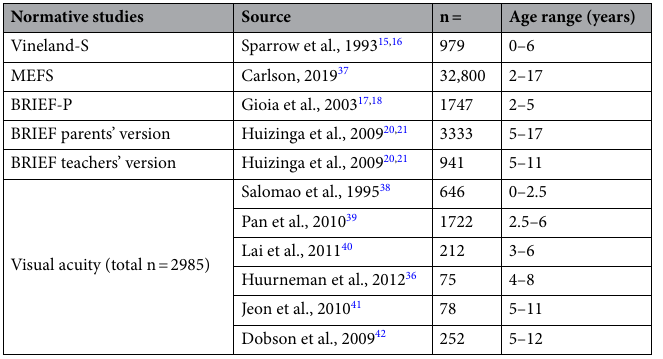
Table 1. Normative studies used. Published studies on typically developing children from which we extracted normative data. For each test, the table lists the source of the normative data (i.e., the published study), the number of included children and their age